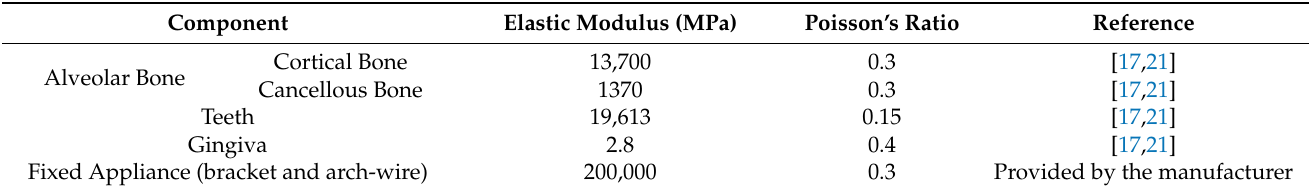
Table 1. Linear Material Properties of the Finite Element